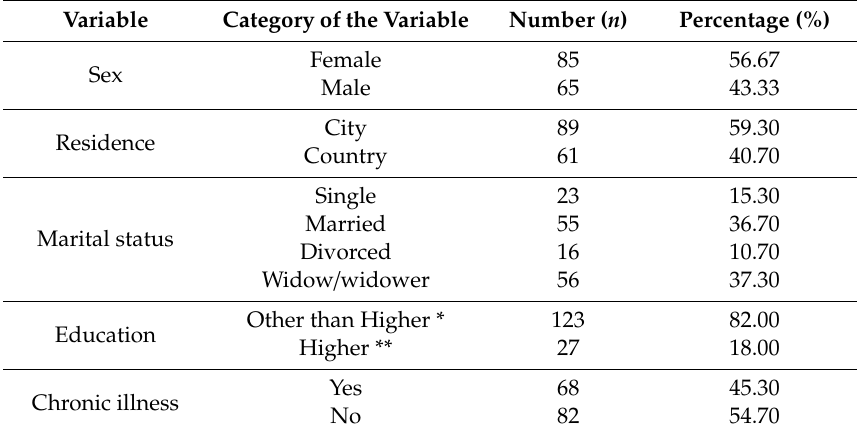
Table 1. Characteristics of the investigated